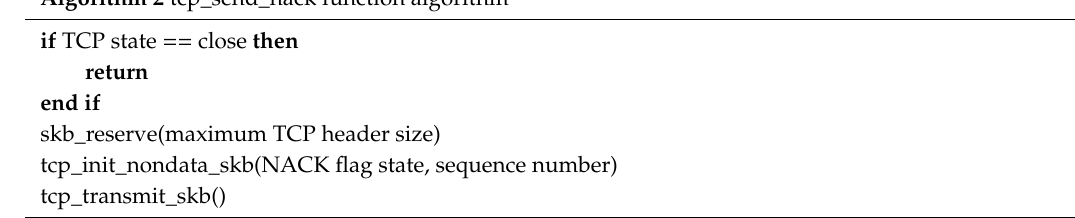
Algorithm 2 tcp_send_nack function